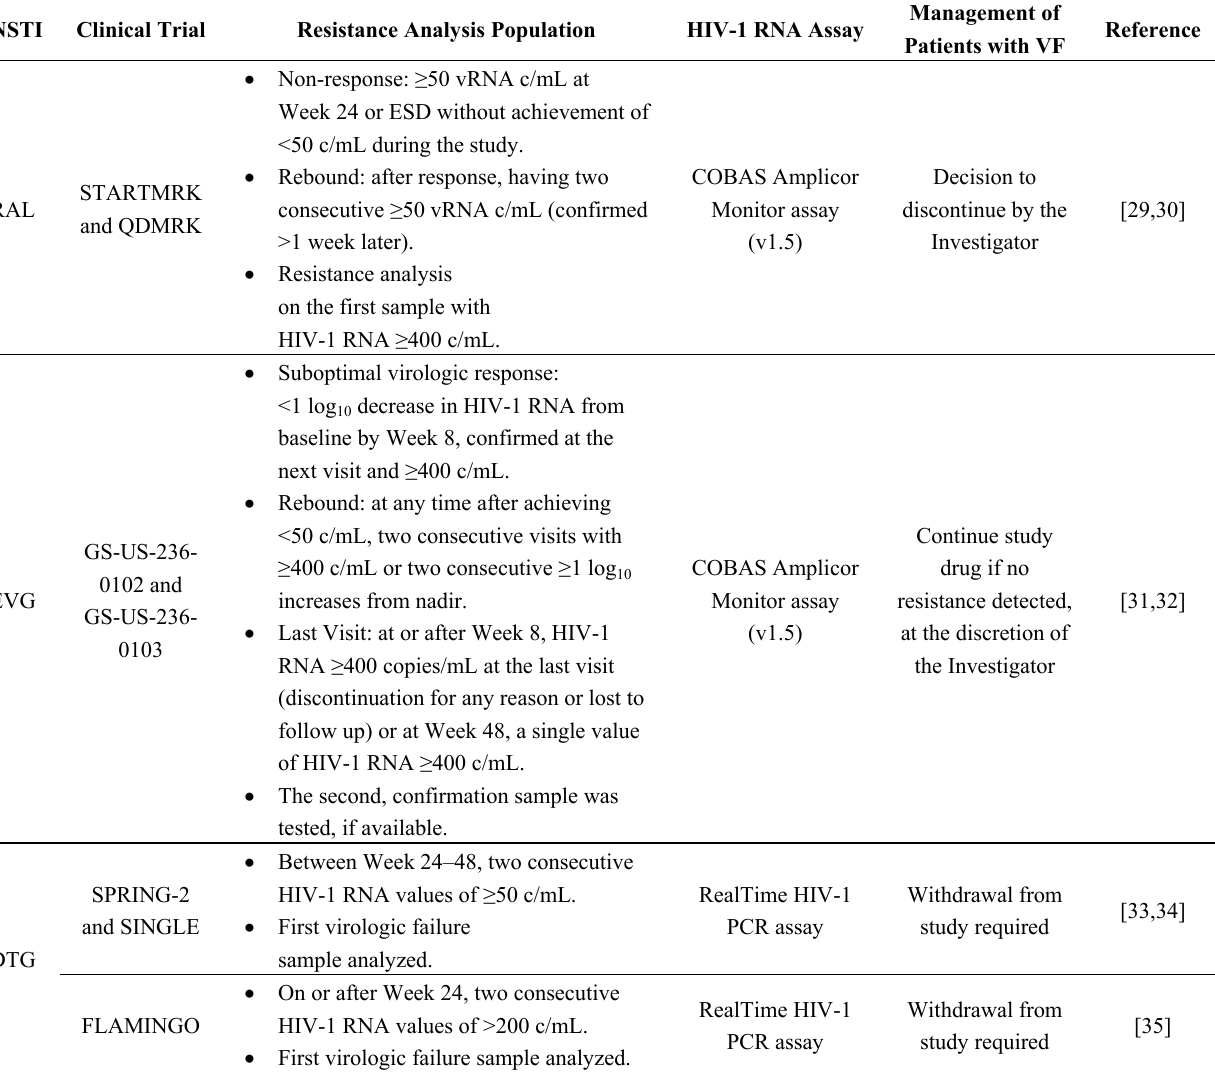
Table 2. Definitions of resistance analysis populations in INSTI clinical